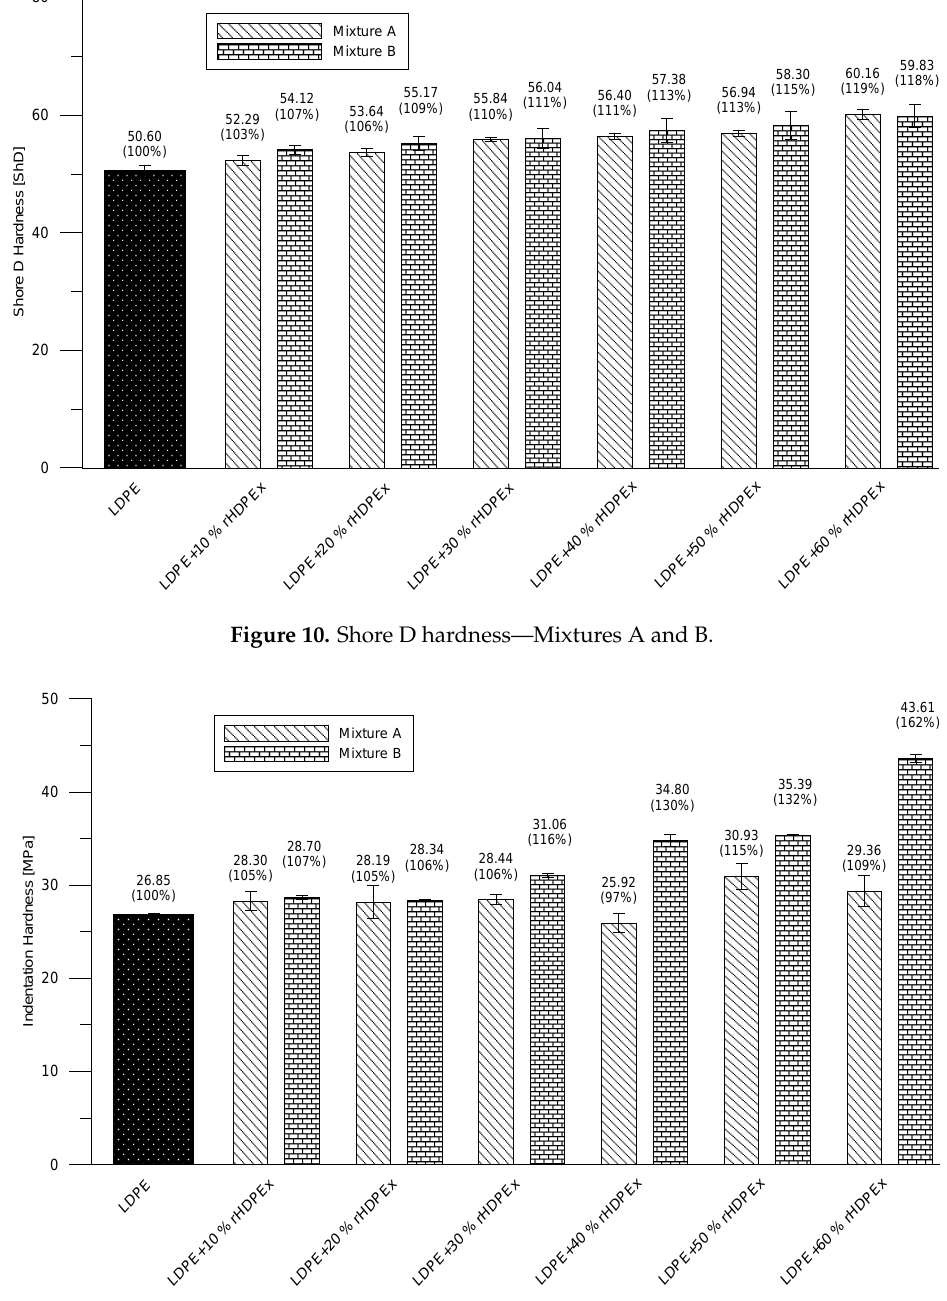
Figure 11. Micro hardness testing—Mixtures A and